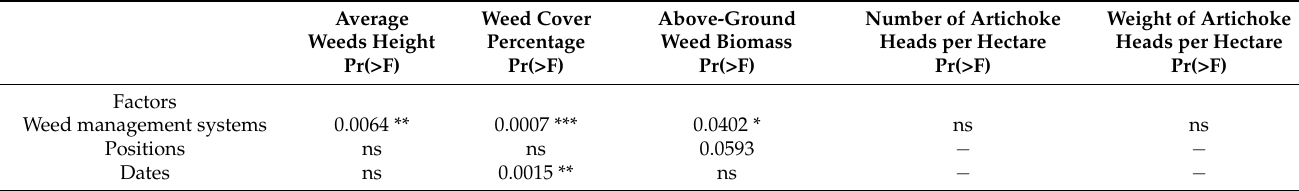
Table 6. Results of three-way Anova testing the effect of weed management systems, positions and dates on average weeds height, weed cover percentage and above-ground weed biomass, and results of one-way Anova testing the effect of weed management systems on artichoke yield